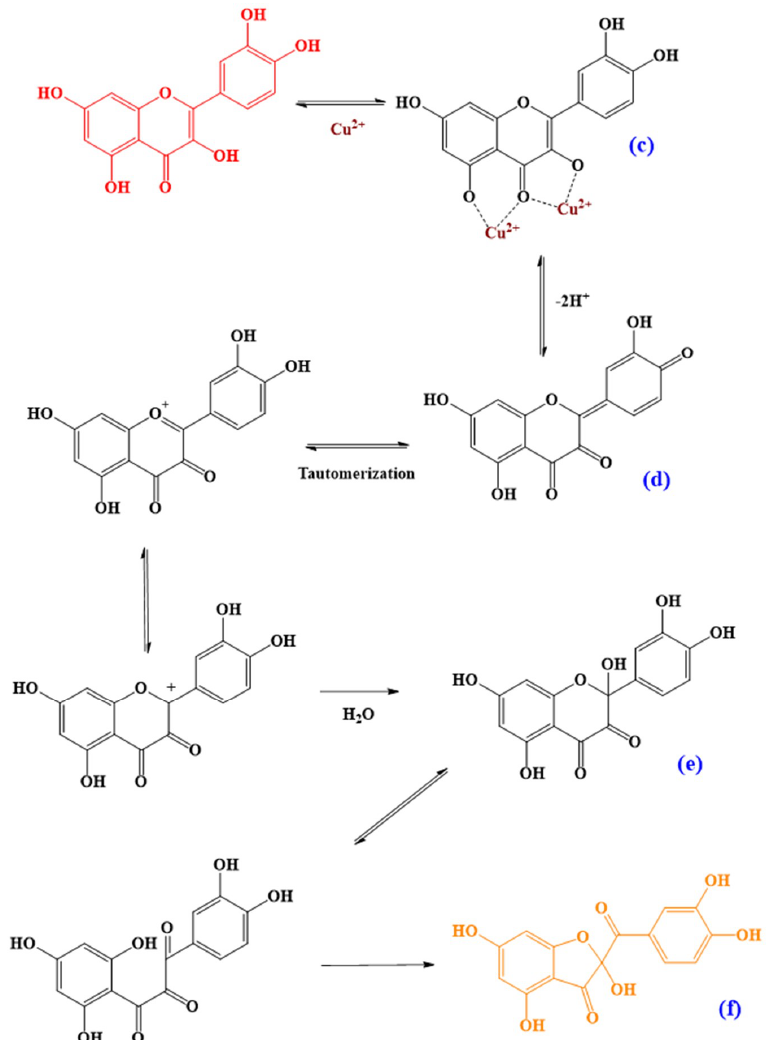
Figure 8. Putative pathway leading to the formation of the 2‐(hydroxybenzoyl)‐2‐ hydroxybenzofuran‐3(2 H )‐one.